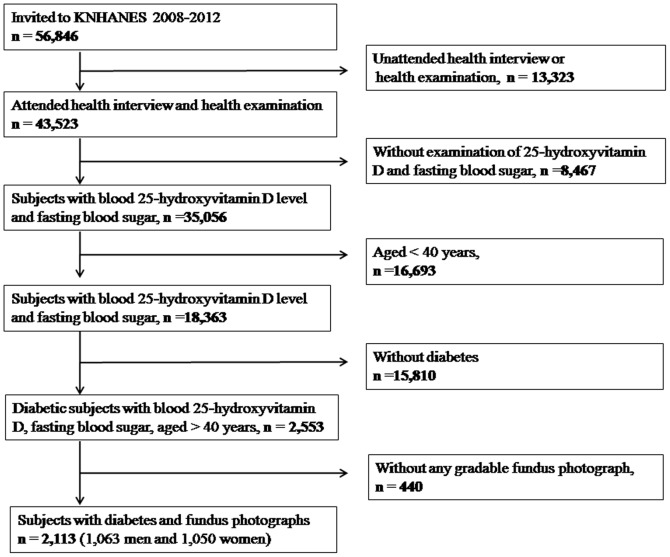
Flow diagram presenting the selection of study participants.